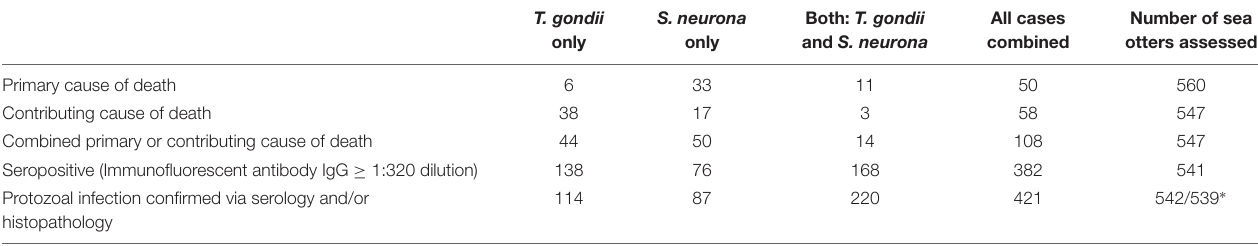
TABLE 5 | Findings for terrestrial protozoan parasite ( Toxoplasma gondii and Sarcocystis neurona or S. sp.) seroprevalence, infection and mortality for 560 southern sea otters ( Enhydra lutris nereis ), 1998 – 2012. Some seronegative sea otters ( T. gondii or S. neurona titers ≤ 1:320 serum dilution) had microscopically-confirmed infection with T. gondii , S. neurona / S. sp., or both parasite groups, resulting in higher totals for confirmed-infected cases than seropositive cases. Fewer otters had confirmed infection with T. gondii only than were seropositive for T. gondii only because some seropositive animals were subsequently confirmed to have concurrent infection with S. neurona and moved to the dual infection column. Please see the text for additional details. T. gondii